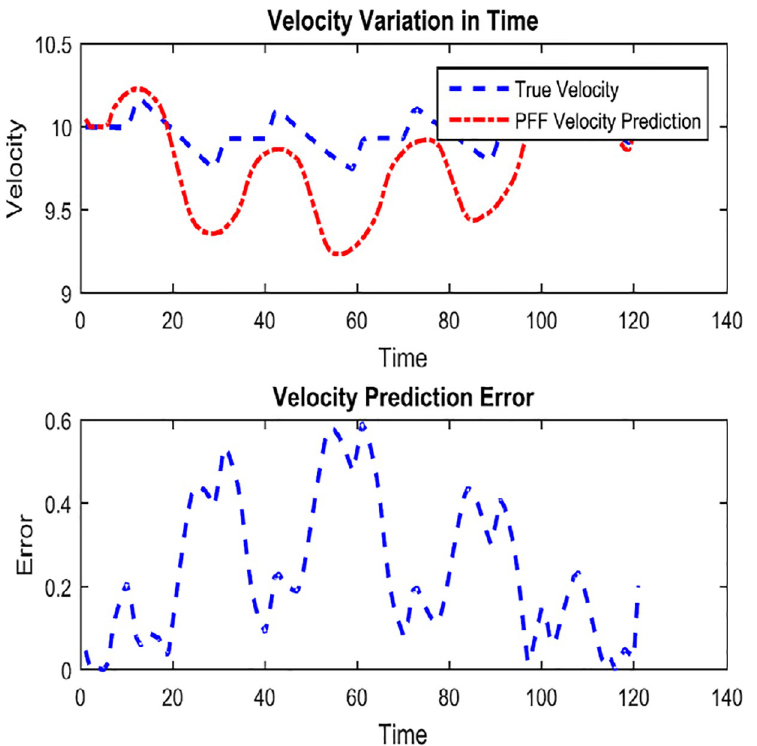
Fig 11. PFF based A-SLAM velocity